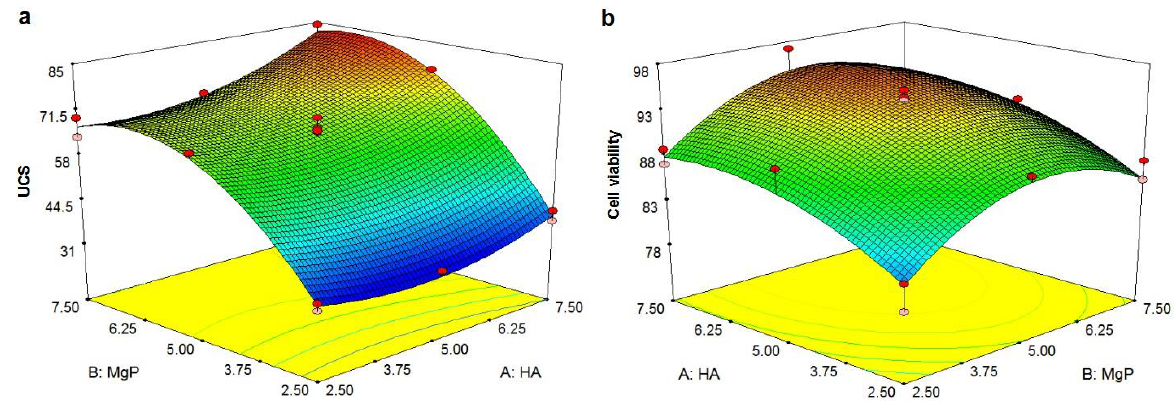
Figure 6. The 3D surface graph: ( a ) UCS and ( b ) cell viability. (Note: it shows the relationship between a response variable Z and two independent factors X and Y. )